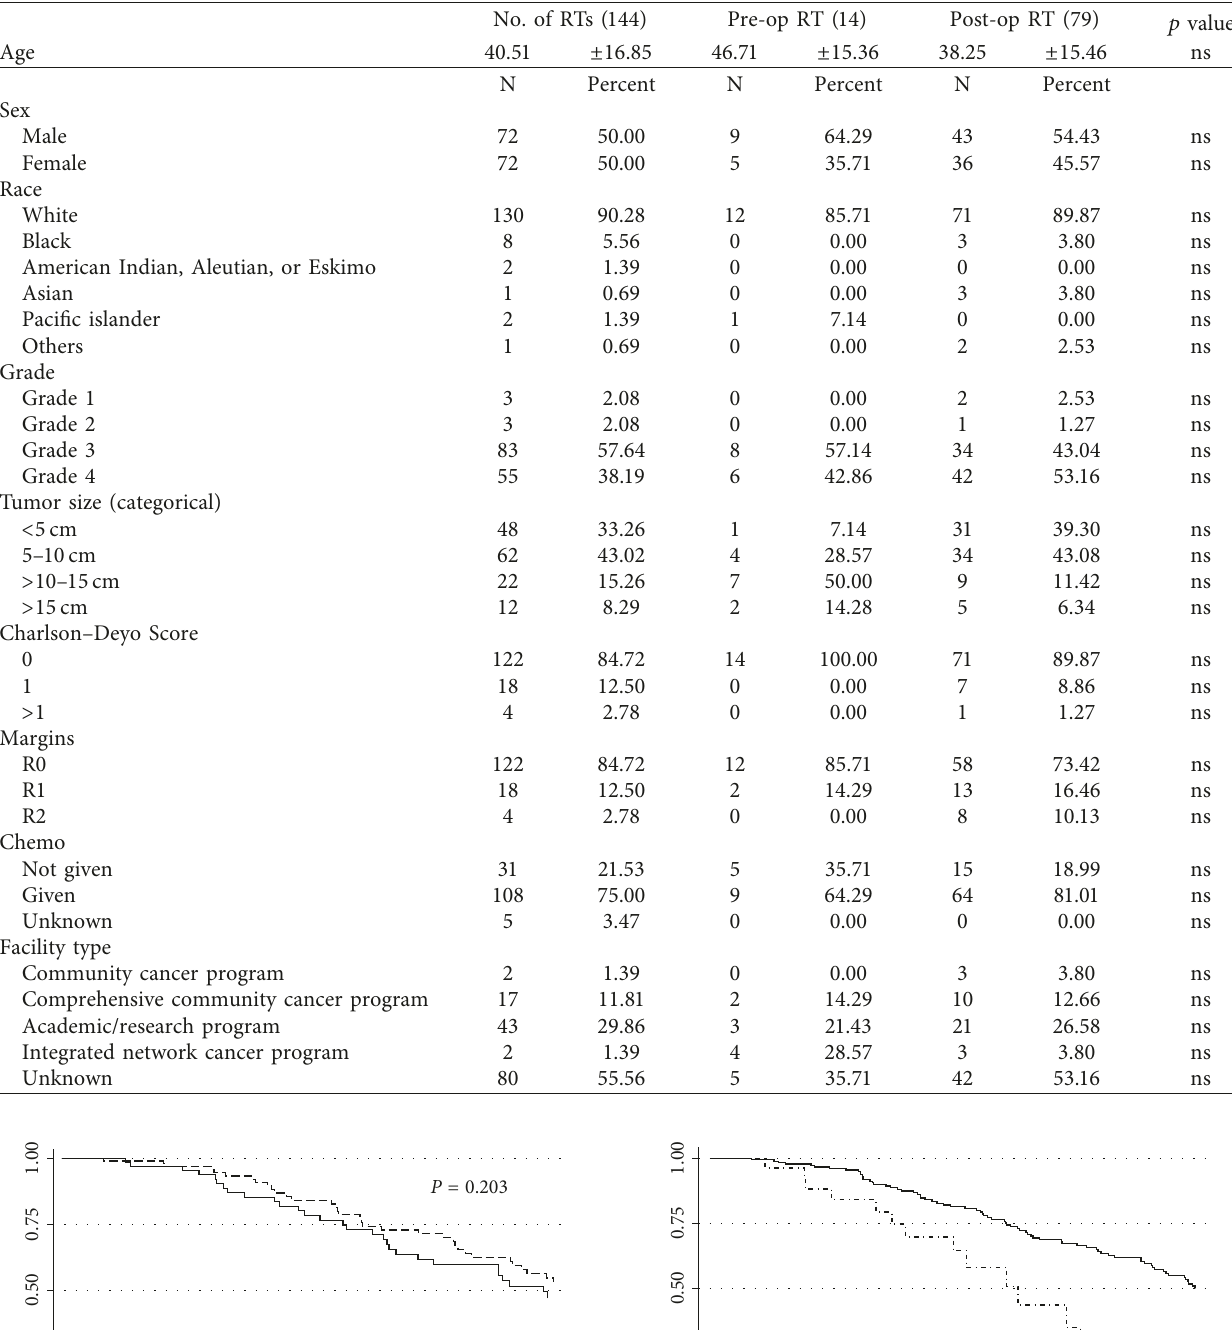
Table 1: Patient demographics and tumor characteristics.